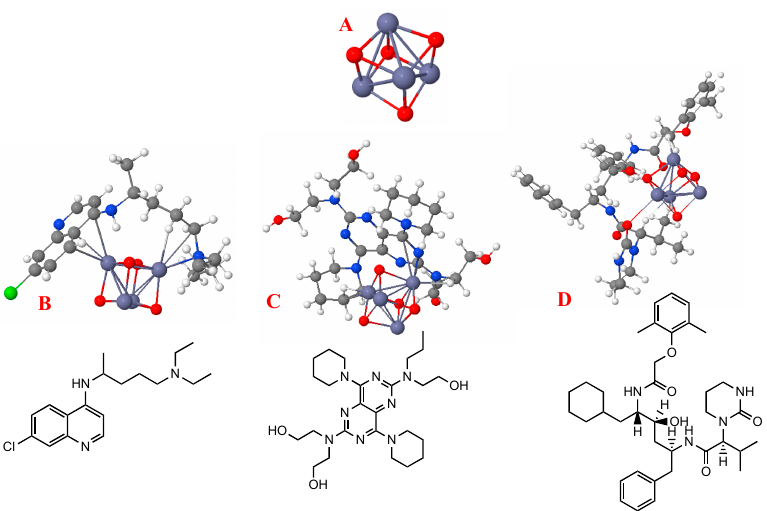
Figure 1. Optimized structures of the ( A ) (ZnO) 4 ‐ NP model and the three designed composites; ( B ) chloroquine coupled to ZnO ‐ NP ((ZnO) 4 ‐ Clq); ( C ) Dipyridamole coupled to ZnO ‐ NP ((ZnO) 4 ‐ Dip), and ( D ) Lopinavir bound to ZnO ‐ NP ((ZnO) 4 ‐ Lop). Gray spheres represent the carbons, red spheres the oxygens, white spheres the hydrogens, blue spheres are the nitrogens, green spheres represent the chloride, and purple spheres are the zinc atoms.